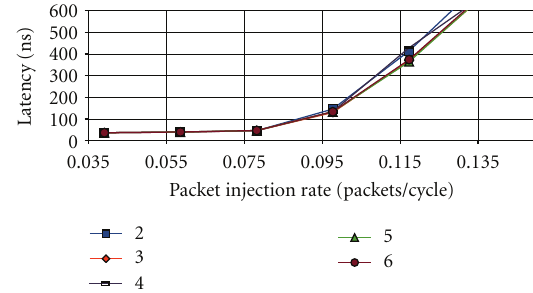
Figure 9: Latency as number of virtual channels is varied for xerox .